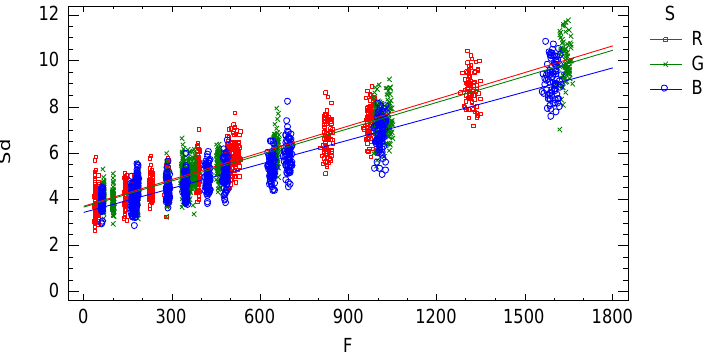
Figure 7. Interaction plot. Standard deviation vs . adjusted radiometric values F depending on the wavelength factor. It is the characterization of the sensor noise (standard deviation) of a single image according to the influential factors.